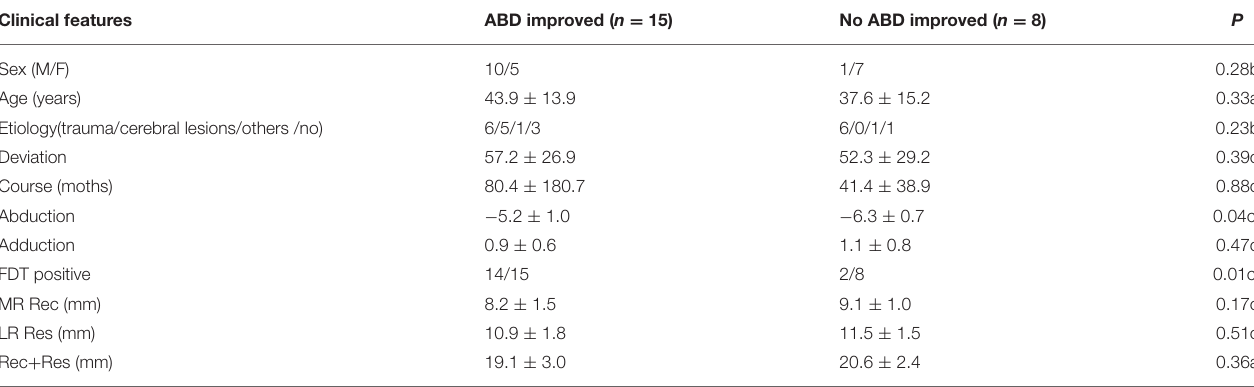
TABLE 4 | Comparison of clinical characteristics between patients with improved and unimproved abduction. Clinical features